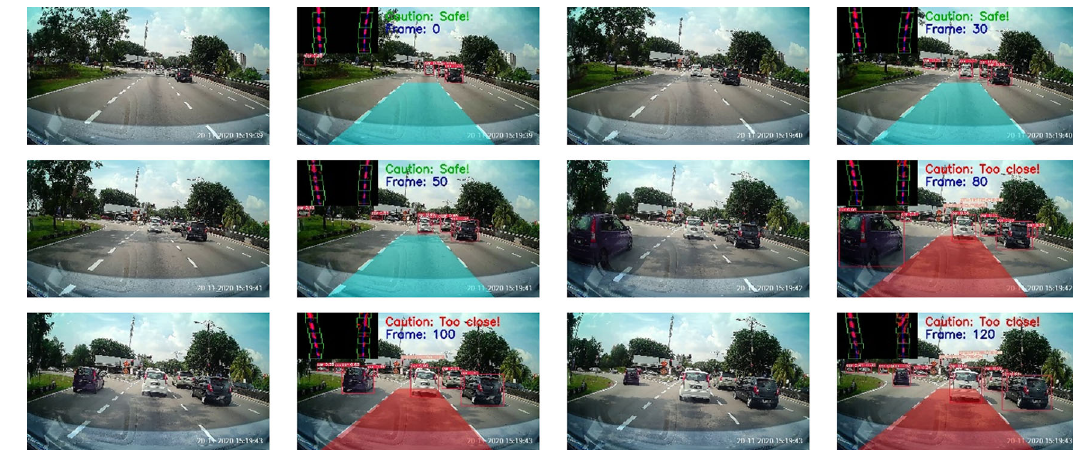
Figure 15. Normal road in the morning.